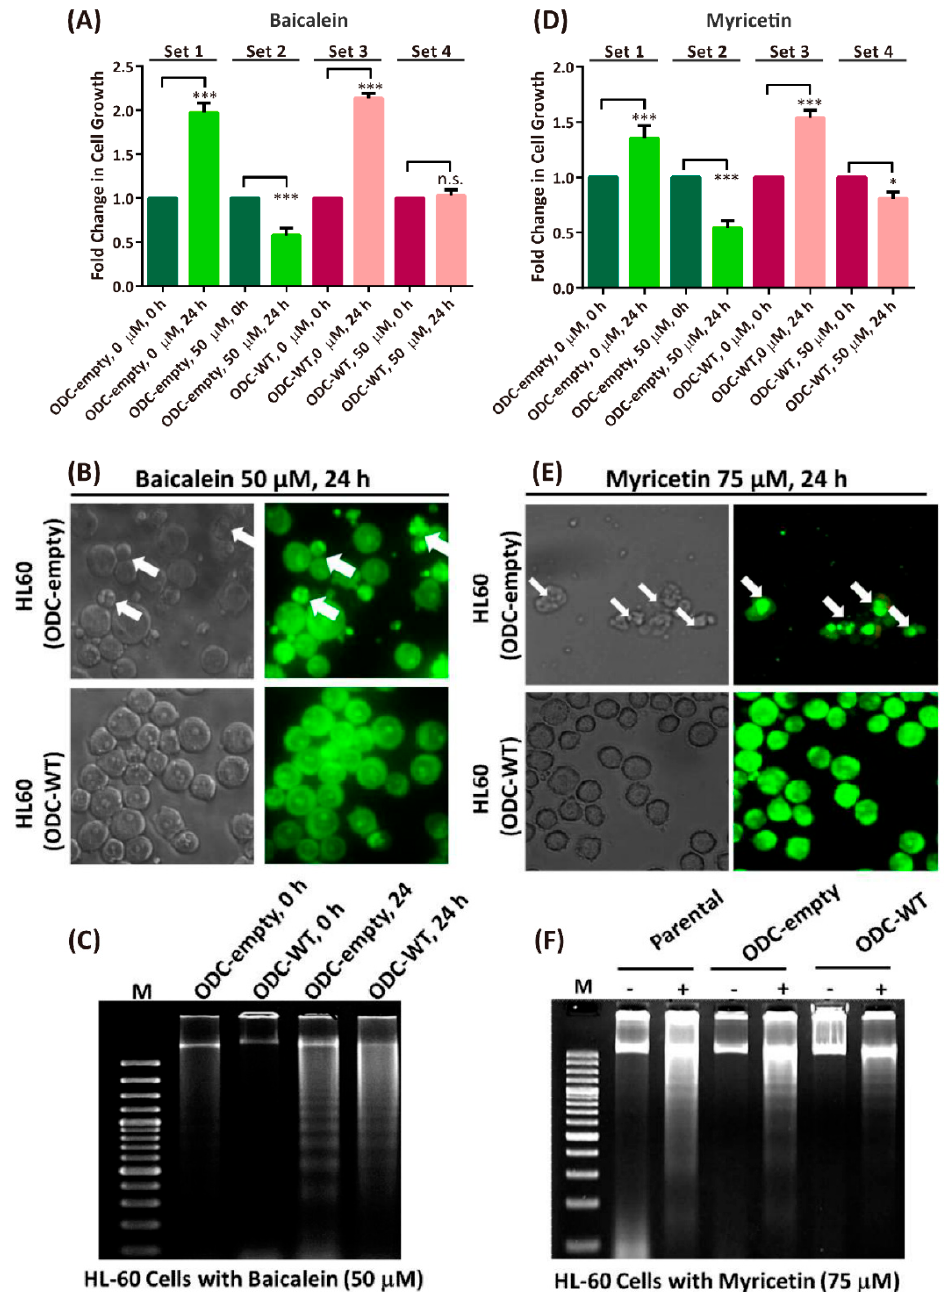
Figure 7. Baicalein and myricetin battled against ODC-evoked cellular anti-apoptosis. ( A , D ) Fold change in growth of HL-60 cells with ODC-empty vector (ODC-empty) and ODC-overexpressing vector (ODC-WT) in the absence or presence of 50 µM baicalein or 75 µM myricetin, respectively. * p < 0.01, *** p < 0.001 ( n = 3). ( B , E ) Apoptotic bodies in the ODC-empty and ODC-WT HL-60 cells (indicated by arrows) were present after treatment with 50 µM baicalein and 75 µM myricetin, respectively. ( C , F ) DNA fragmentation in the ODC-empty and ODC-WT HL-60 cells (indicated by arrows) was present after treatment with 50 µM baicalein and 75 µM myricetin, respectively.